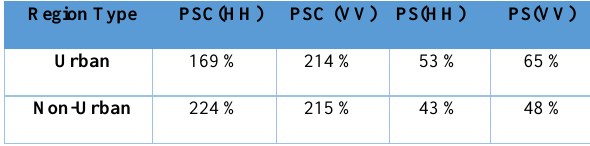
Table 1. Extra PSC/PS pixels detected by using polarimetric data, compared by HH and VV channel